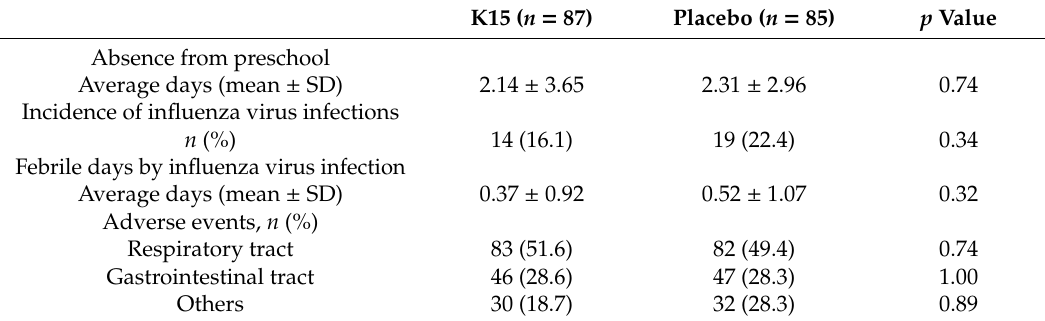
Table 3. Secondary outcomes and adverse